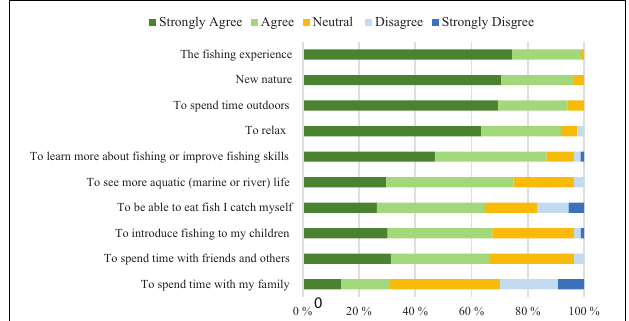
FIGURE 3 | Anglers’ motivations to fishing sea trout.